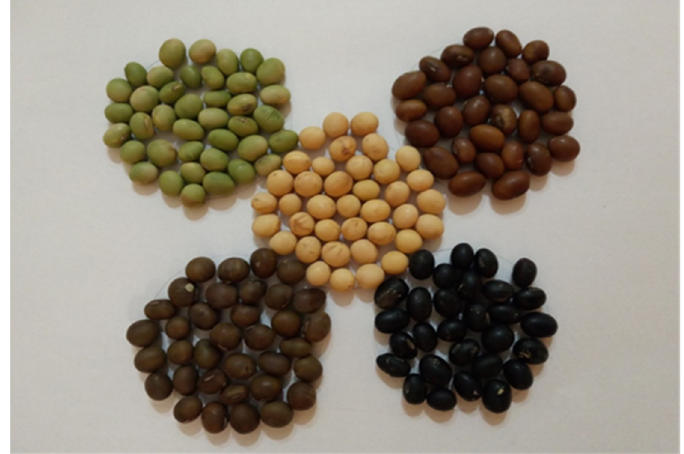
Figure 1. Genotypes included in the